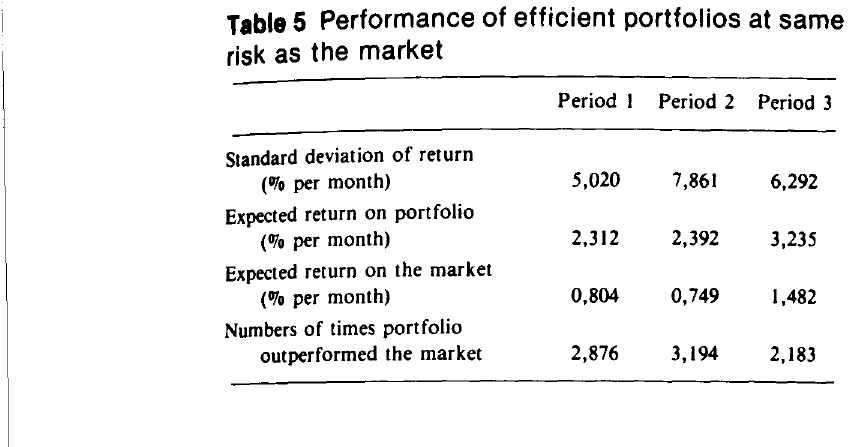
Table 5 Performance of efficient portfolios at same risk as the